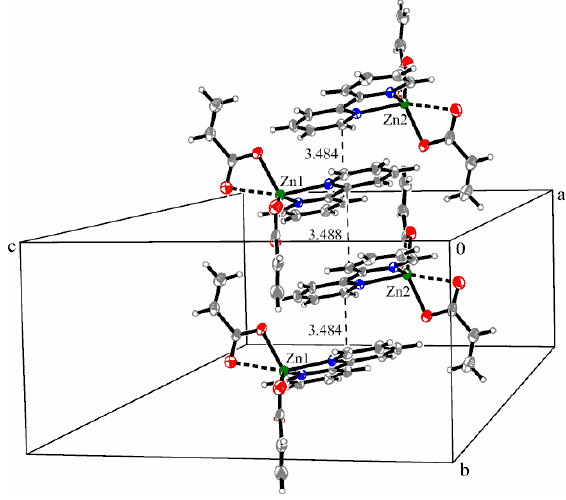
Figure 8. Packing diagram presenting the π … π interactions along the b -axis in complex ( 4 ).